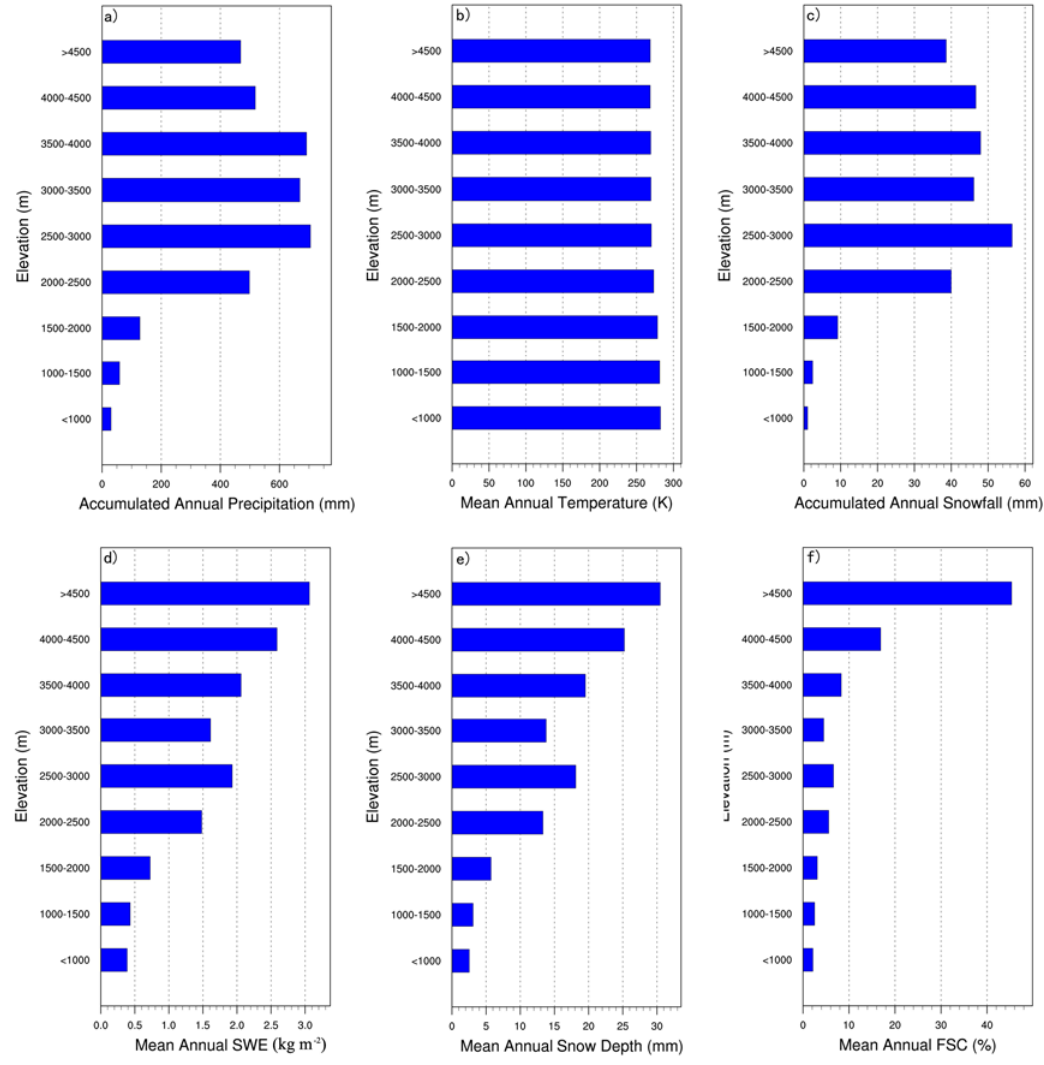
Figure 4. Altitudinal profiles of annual mean values from 2000 to 2013: ( a ) precipitation; ( b ) 2m temperature; ( c ) snowfall; ( d ) SWE; ( e ) snow depth; ( f ) FSC.